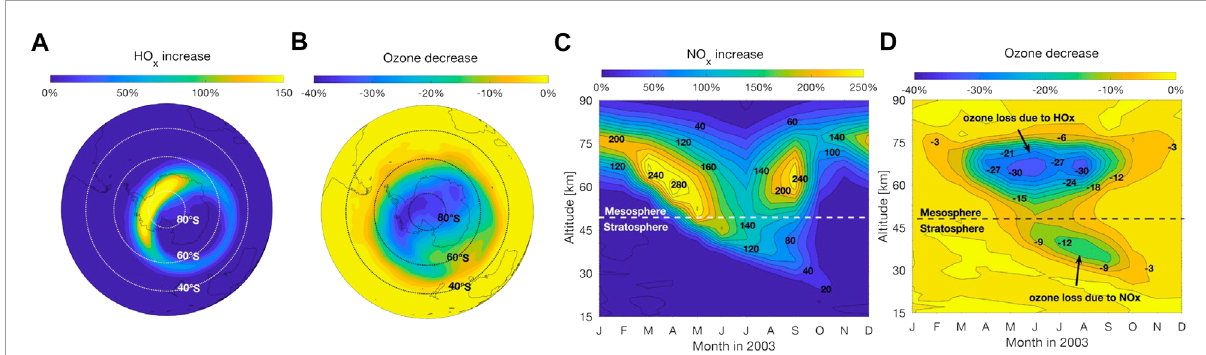
FIGURE 4 Middle atmospheric impact from using Daedalus-based EPP forcing, based on WACCM chemistry-climate simulations over (maximum EPP) year 2003. (A) Mean SH odd hydrogen ( HO x ) increase in June-August at 65–75 km altitude, relative to simulations using the CMIP6 EPP forcing; (B) Same as (A) , but for O 3 decrease; (C) Monthly mean odd nitrogen ( NO x ) increase in the SH polar cap, relative to simulations using the CMIP6 EPP forcing; (D) Same as (C) , but for O 3 decrease. For reference, the NO x mixing ratio background peaks in the uppermost mesosphere and